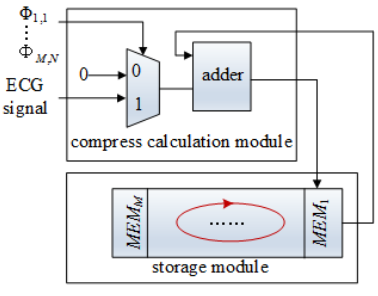
Figure 5. The compression process.